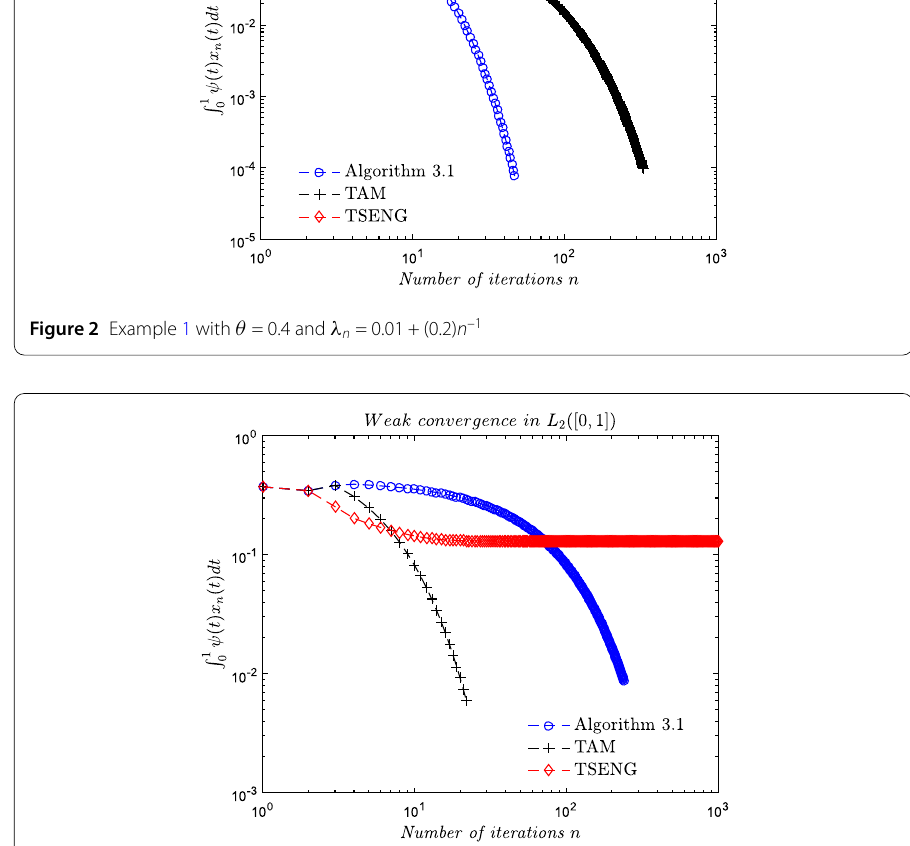
Figure 3 Example 1 with θ = 0.01 and λ n = 0.1250 + (0.0156) n